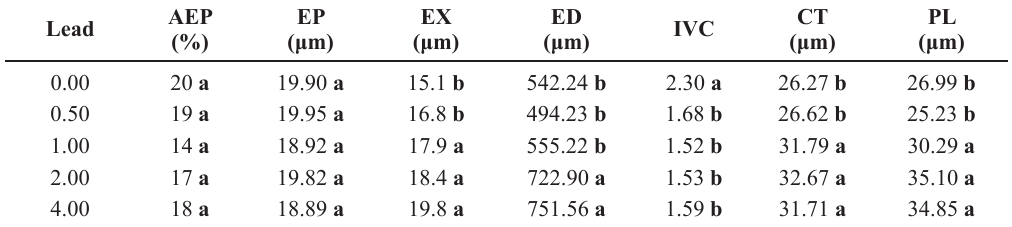
Figure 3 - Root cross sections in Eichhornia crassipes grown in nutrient solutions containing different lead concentrations. ep = epidermis, ex = exodermis, er = aerenchyma chamber, ed = endodermis, xl = xylem, pl = phloem. A = 0.00 mg L -1 , B = 0.50 mg L -1 , C = 1.00 mg L -1 , D = 2.00 mg.L -1 , E = 4.00 mg.L -1 . bars = 100 μm. III Root anatomical characteristics of water hyacinth ( Eichhornia crassipes ) grown under different lead concentrations (mg L -1